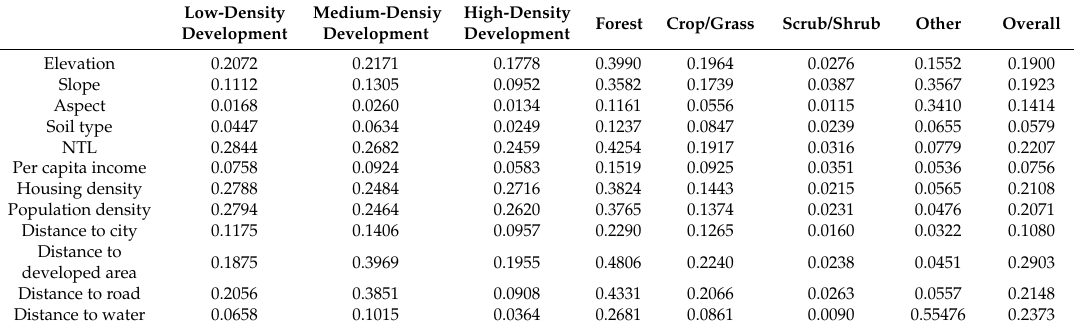
levels of the explanatory variables (drivers) and the studied land use/cover distribution.